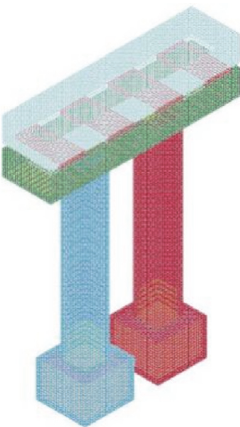
Figure 3: Numerical model of RC pier.